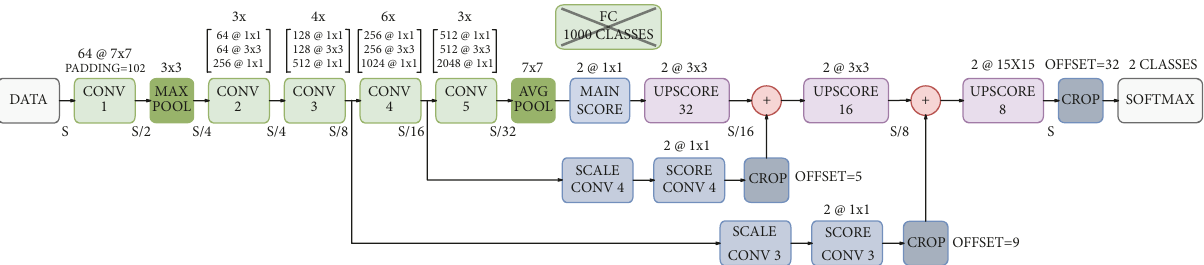
2.2. Map Road Model Fitting. The simplest geometric models used for road boundaries are straight lines. Due to the